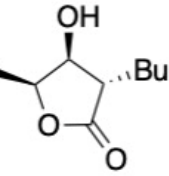
Figure 6. The structure of epi-blastmycinolactol ( 45 ) [84] .